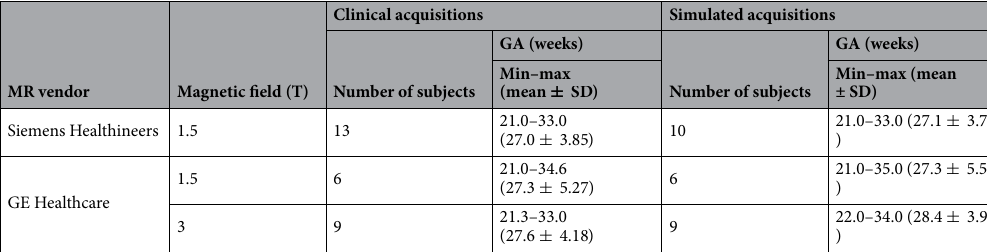
Table 3. Number of subjects, either scanned or simulated, considered throughout this study and distribution of gestational age (GA) according to the MR vendor and the main magnetic field strength.